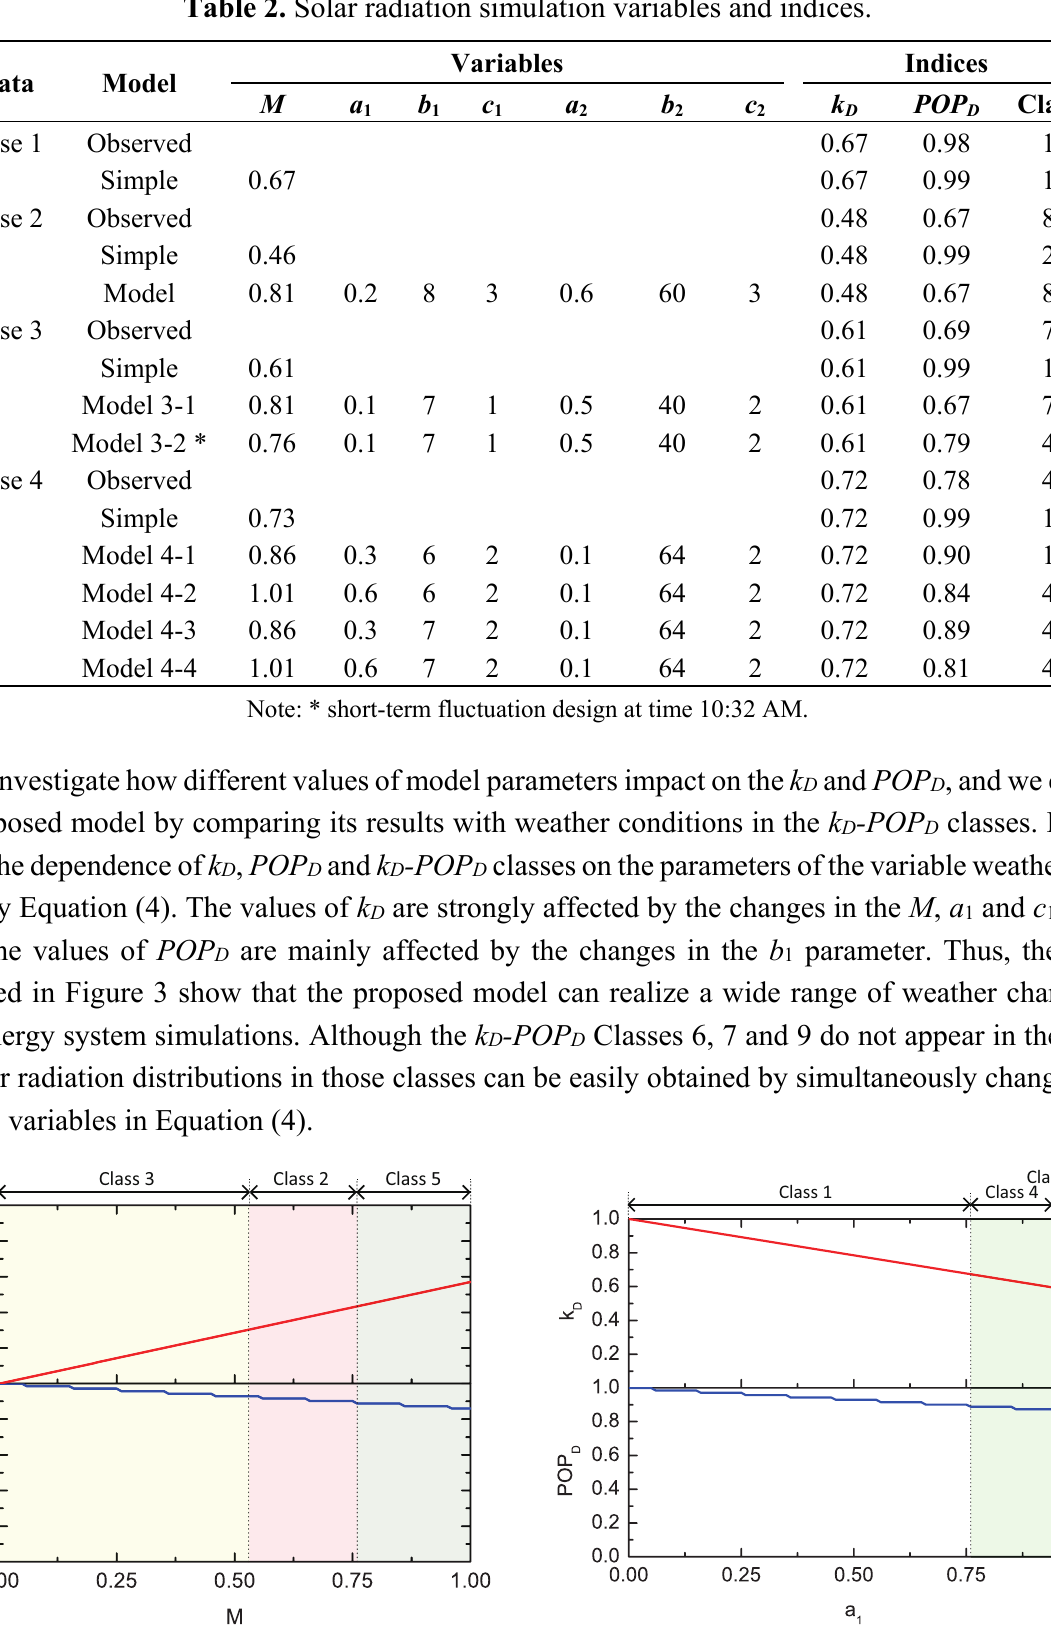
Table 2. Solar radiation simulation variables and